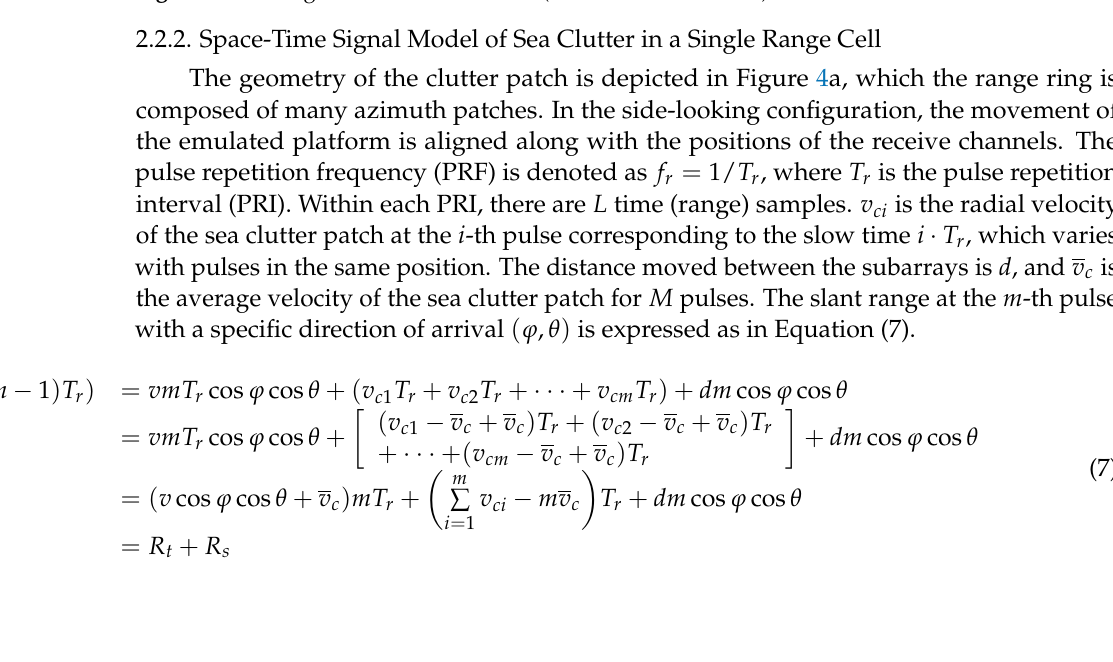
Figure 5. The single channel data matrix (slow time fast time).